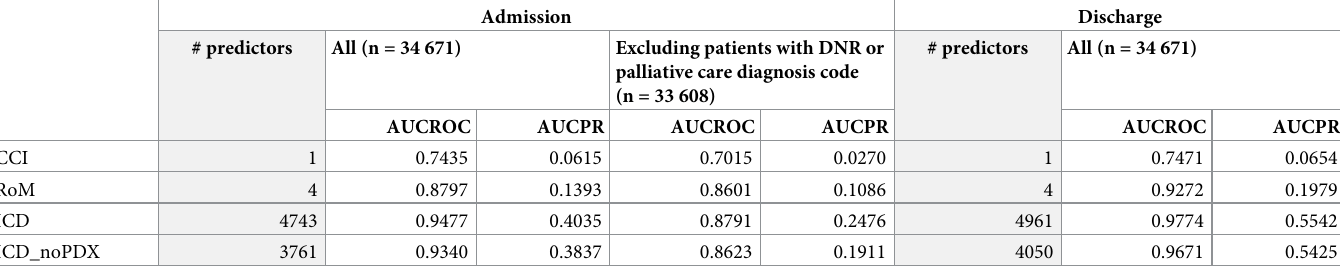
Table 2. Model AUC results.